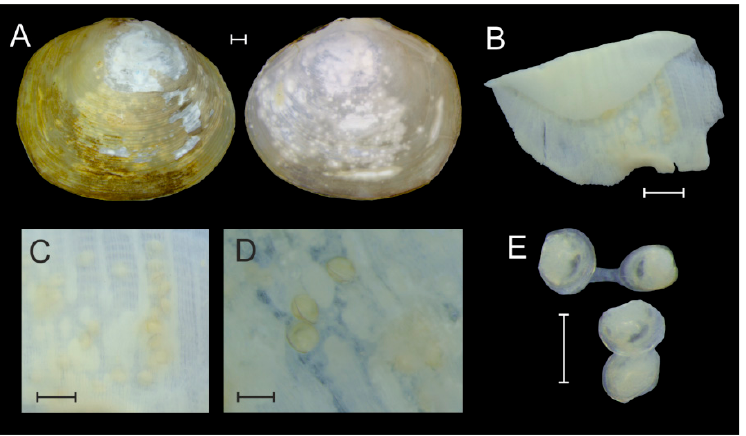
Figure 1. Morphology and anatomy of Corbicula tobae from Lake Toba, North Sumatra, Indonesia (lot Nos. RMBH MCorb-17 and RMBH MCorb-93). ( A ) Valve from the outer and inner sides; ( B ) gills of an incubating specimen; ( C , D ) detail of the same gill; ( E ) larvae. Scale bars ( A , B ) = 1 mm; ( C ) = 0.5 mm; ( D , E ) = 0.25 mm.